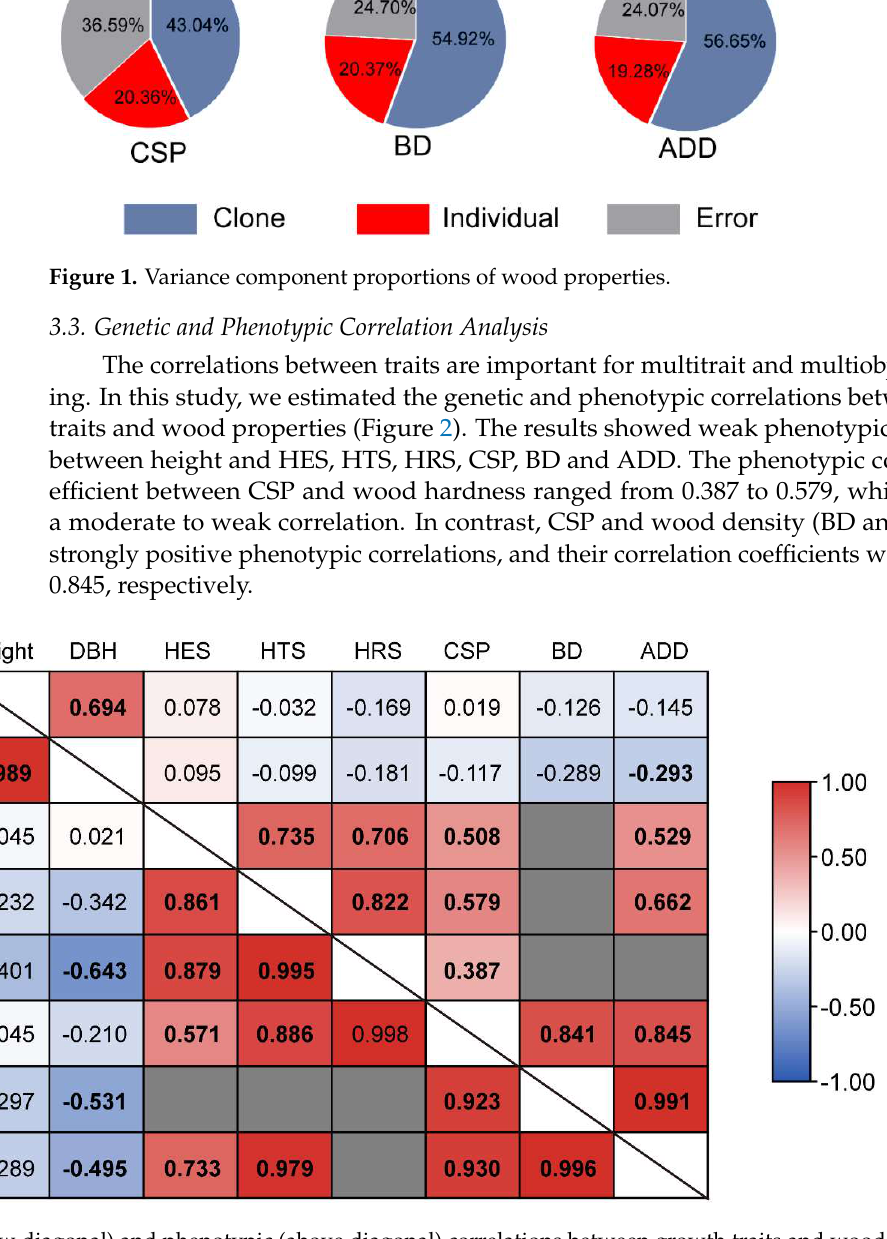
Figure 2. Genetic (below diagonal) and phenotypic (above diagonal) correlations between growth traits and wood property traits. Bold text indicates statistical significance ( p < 0.05). The parameters in the gray area could not be accurately